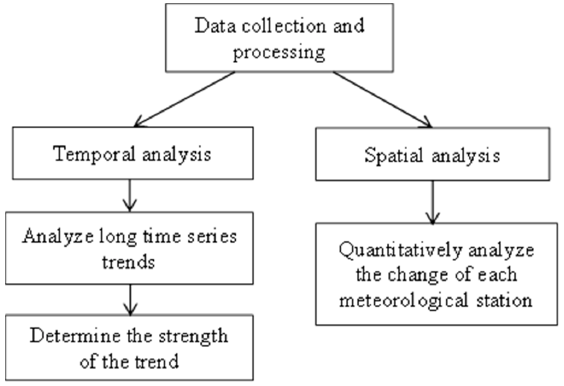
Figure 2. Data processing flow chart.